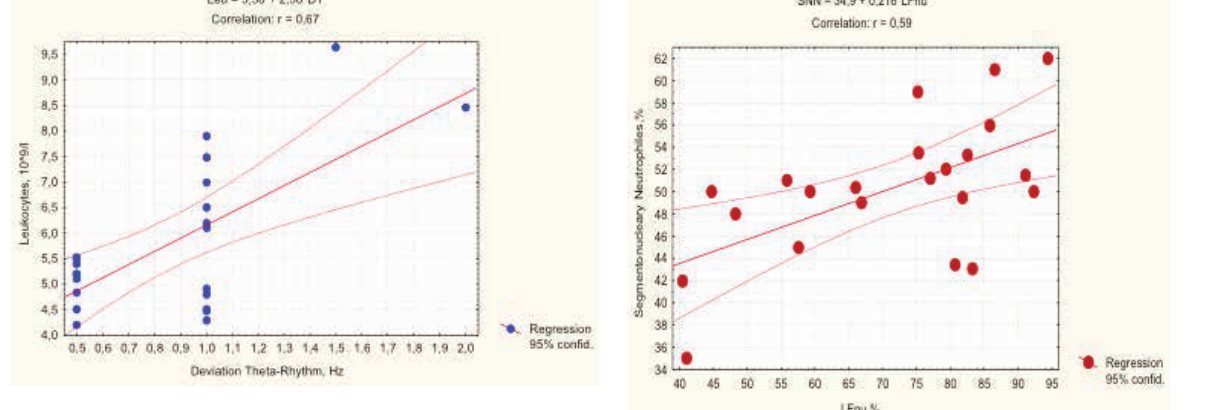
Figure 1: Relationship between deviation of θ-Rhythm (X-line) and blood level of Leukocytes (Y-line)